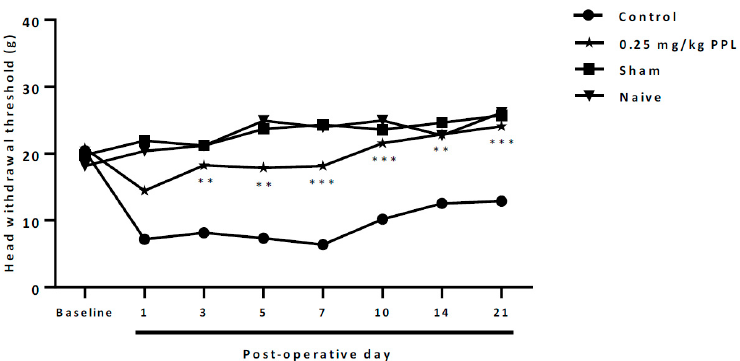
Figure 5. Antihyperalgesic effect of repeated PPL treatment after the infraorbital nerve transection. ANOVA followed by the Bonferroni test ** p < 0.01 and *** p < 0.001 vs Control. ANOVA followed by the Bonferroni test. PPL = 0.25 mg/kg PPL.